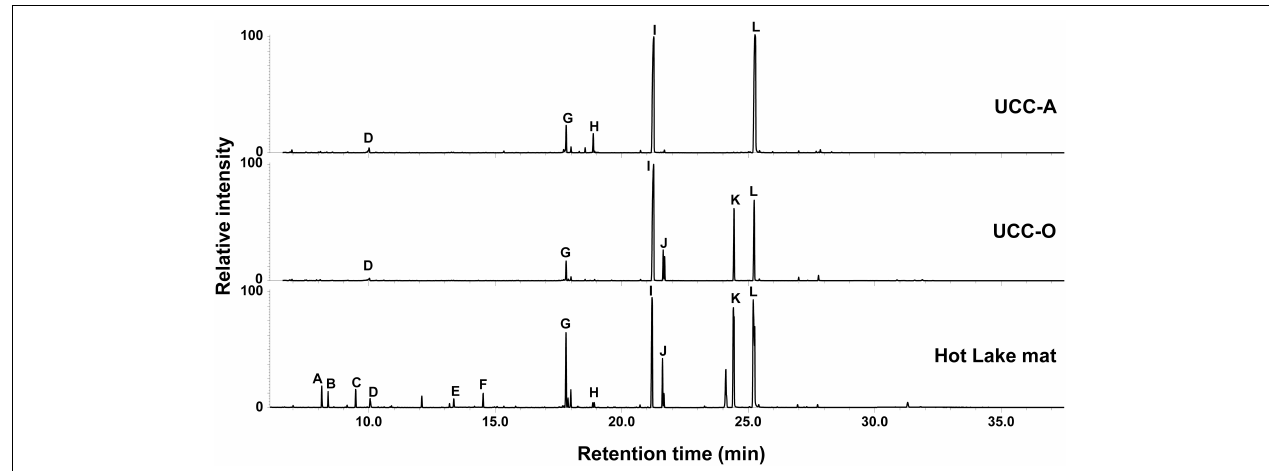
FIGURE 4 | Metabolic analysis of the consortia and the Hot Lake mat community. GC-MS chromatograms depict polar metabolites identified by retention time and mass spectrum. Metabolite peaks are identified as